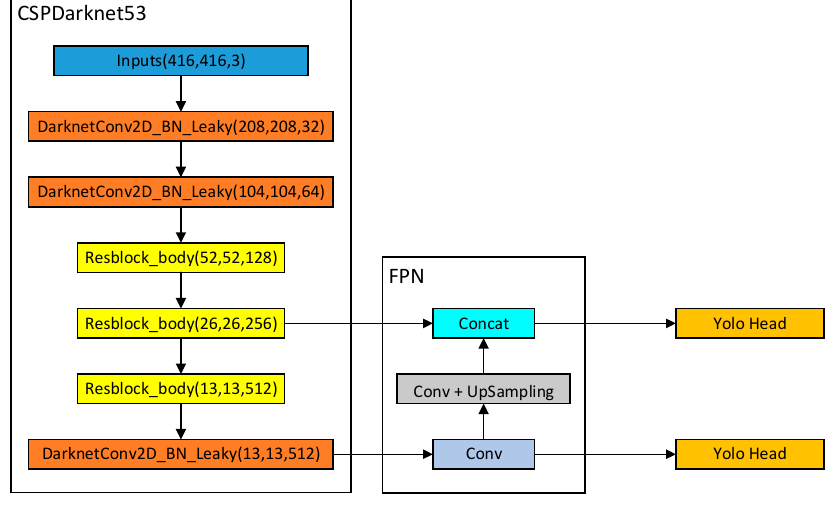
Figure 1. YOLOv4-tiny model structure.